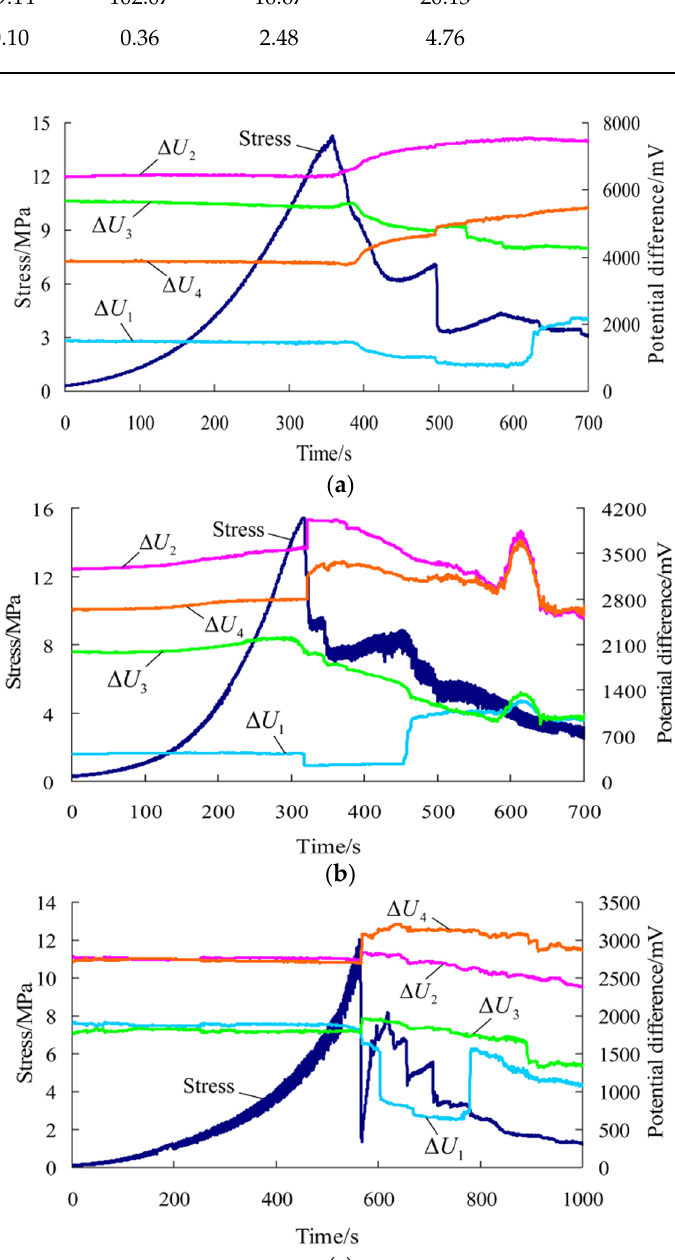
Figure 3. Stress-time curve and time-varying curve of the potential difference in each direction during the whole process of uniaxial compression for rock samples parallel to the bedding direction. ( a ) Rock sample 6-1; ( b ) Rock sample 7-1; ( c ) Rock sample